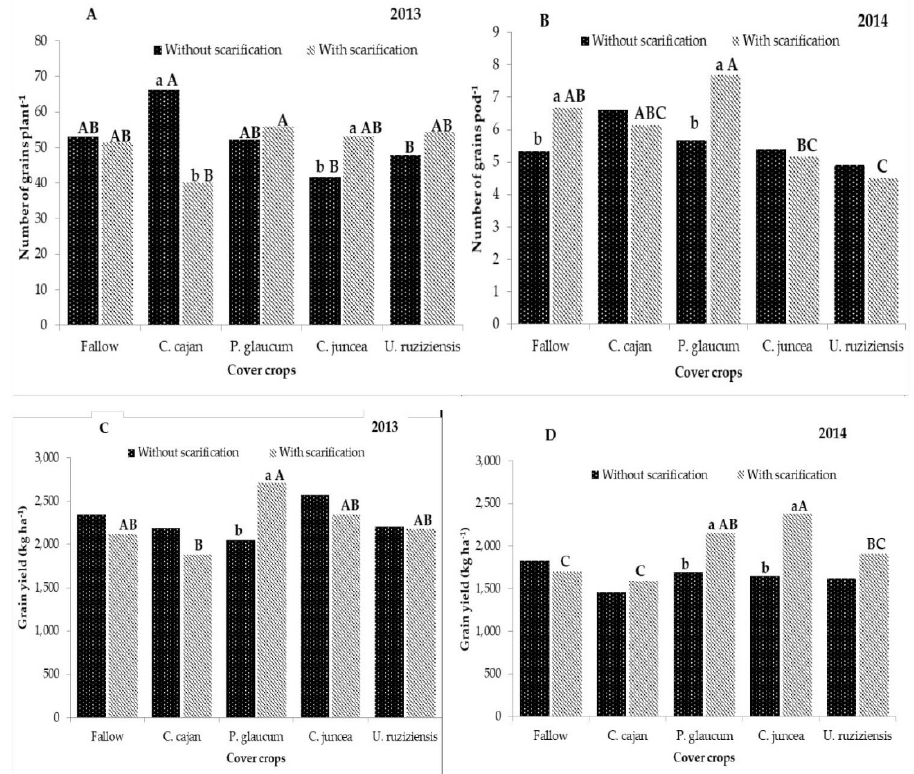
Figure 3. Significant interactions for number of grains per plant in 2013 ( A ), number of grains per pod in 2014 ( B ) and grain yield in 2013 and 2014 ( C , D ) of “winter” common bean after mechanical soil chiseling (MSC) and predecessor cover crops (CC) implanted in NTS. Averages followed by the same lowercase letter for CC within MSC and capital letters for MSC within CC did not statistically differ by Tukey test at 5% significance, respectively.